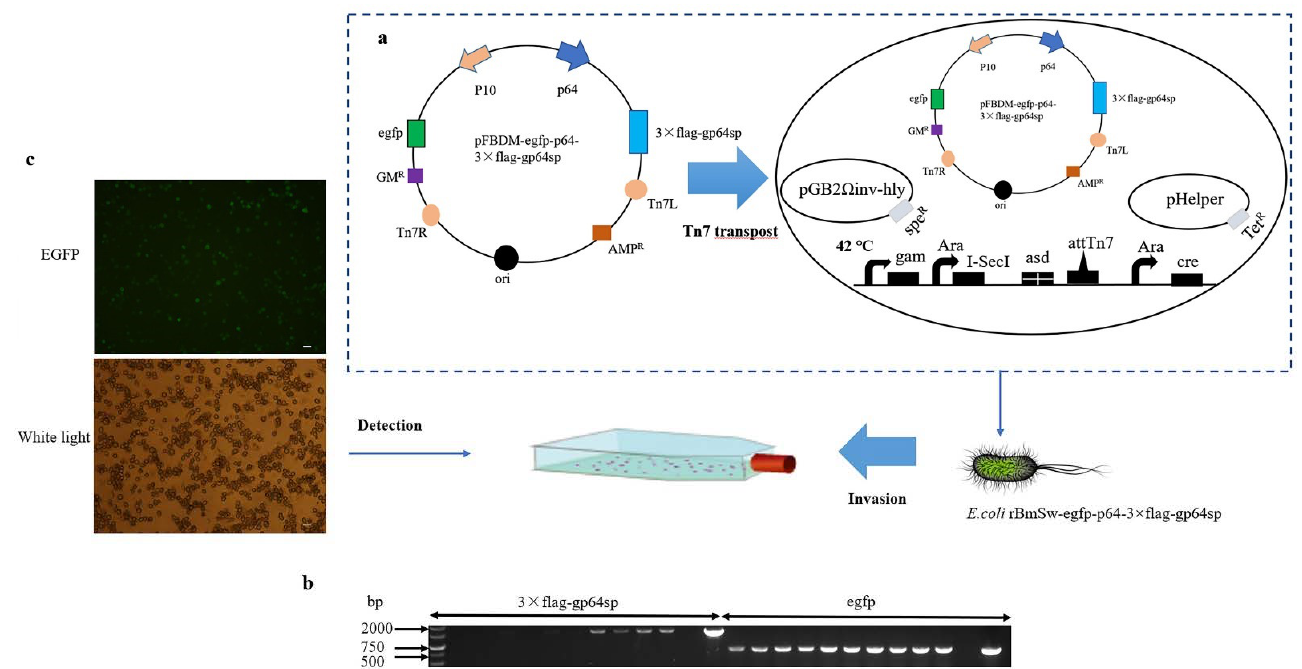
Figure 3. Schematic diagram of recombinant baculovirus construction. ( a ) Transfer vector to E. coli BmSw106 via Tn7 transfer site to construct new recombinant E. coli rBmSw106-egfp-p64. ( b ) Determination of the success of recombinant E. coli rBmSw106-egfp-p64 construction by PCR detection of gp64 and egfp genes. ( c ) Detection of primary recombinant baculovirus BmBV-egfp-p64-3×flag-gp64sp production by inverted fluorescence microscope (bar = 100 μ m).